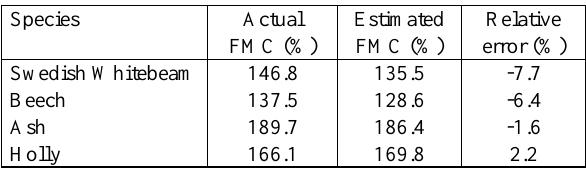
Table 2. Relative errors in the FMC estimations.